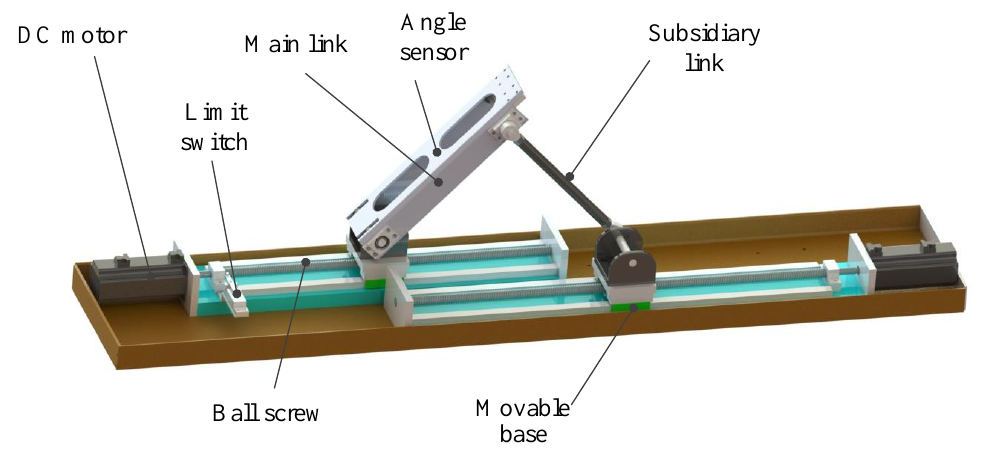
Figure 2. Main motion module.